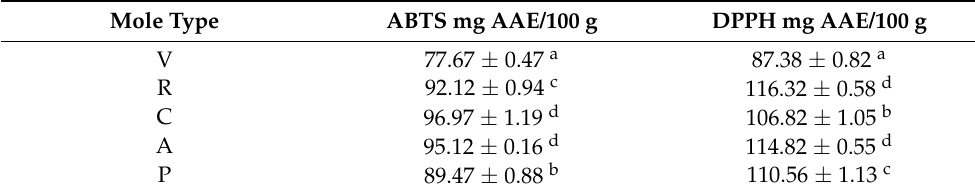
Table 8. Antioxidant activity of five types of mole from the State of Hidalgo, by the ABTS and DPPH method expressed in ascorbic acid equivalents (mg AAE/100 g of dry base sample). Mole